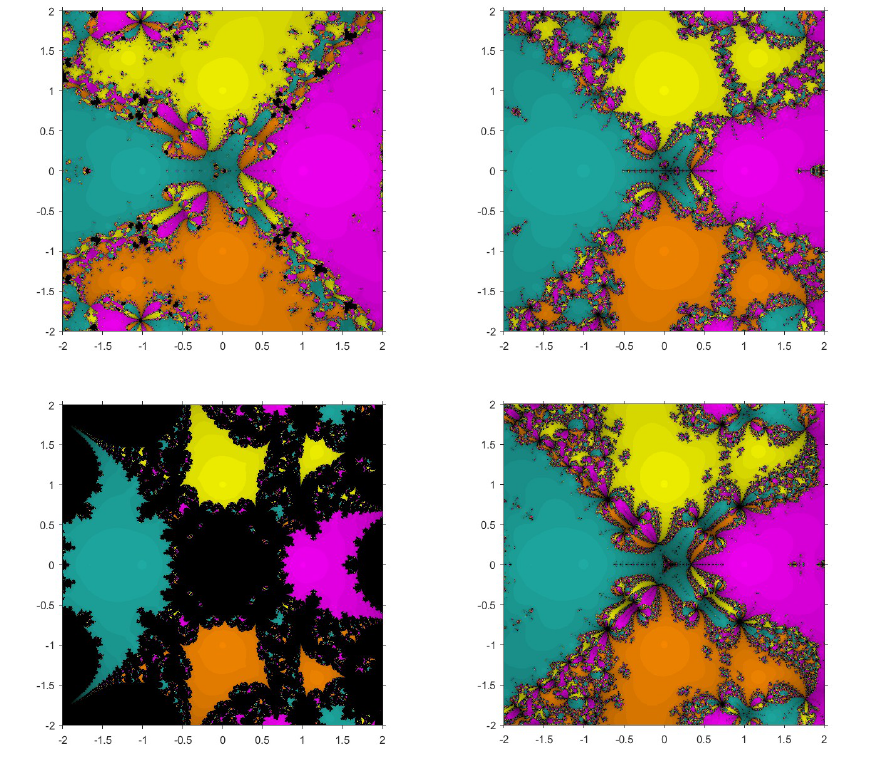
Figure 6. Basins of attraction for PMM , AM 2 , DM 1 , and DM 2 , respectively, for p 3 ( z )